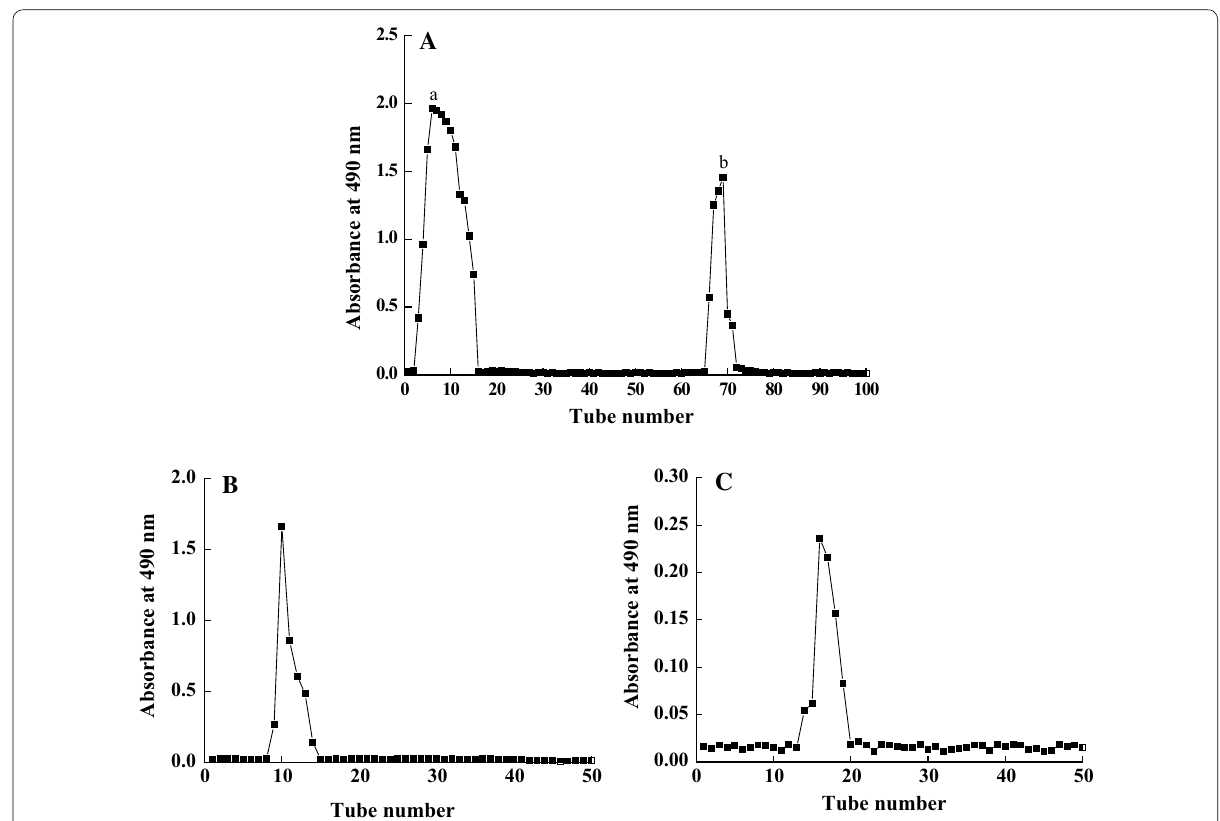
Fig. 1 Purification of polysaccharides. A DEAE-52 anion-exchange column chromatography elution curve of crude polysaccharide extracted from Dendrobium officinale leaves. B , C Sephadex G-100 column chromatography elution curves of fraction a and b